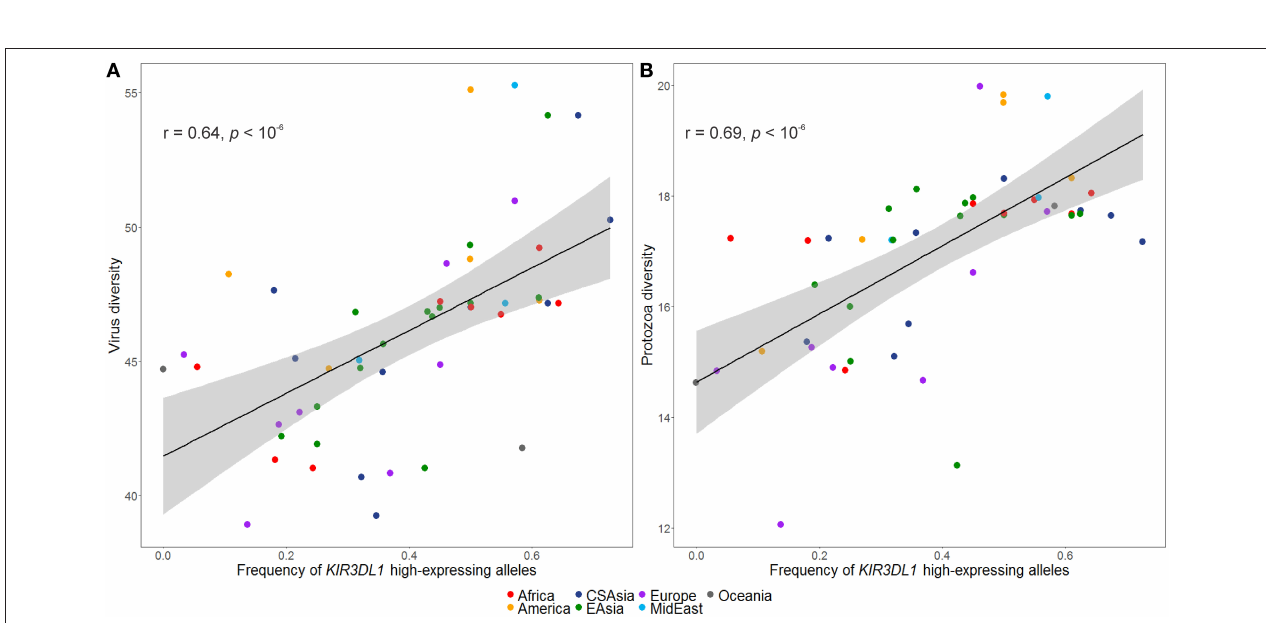
FIGURE 4 | Inferred worldwide frequencies of KIR3DL1S1 allelic lineages . The inference was based on the pair of SNPs rs592645 and rs35656676 , which mark the KIR3DS1 (D’ = 0.98) and KIR3DL1 high- and low-expressing lineages (D’ = 1.0), respectively. MidE, Middle East; CSAsia, Central and South Asia; EAsia, East Asia; Amer, America; Oce, Oceania.